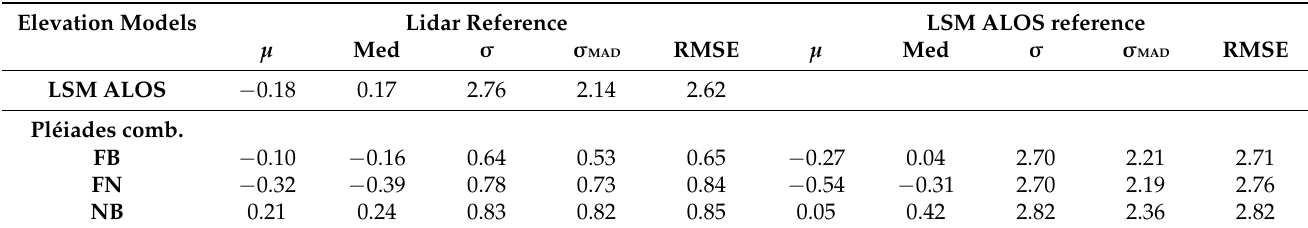
Table A1. LSM ALOS (after LSM to Lidar) vertical accuracy with reference to Lidar and comparison of Pléiades DEMs with respect to Lidar and LSM ALOS in open areas (given values are in meters).